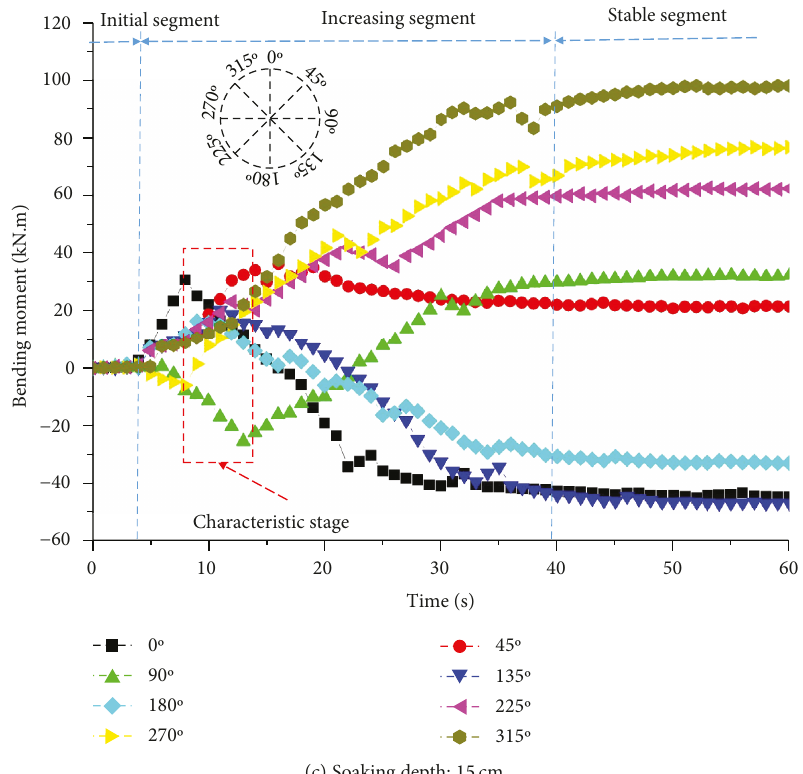
Figure 12: Bending moment of half-range soaking with operating time.